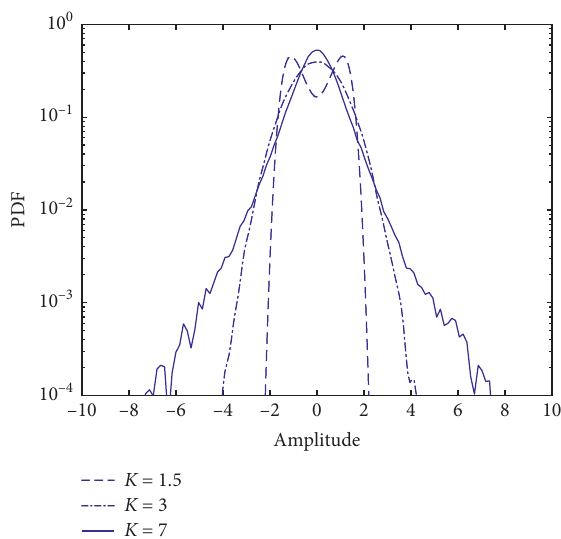
Figure 2: Probability distribution of three signals with different kurtoses.